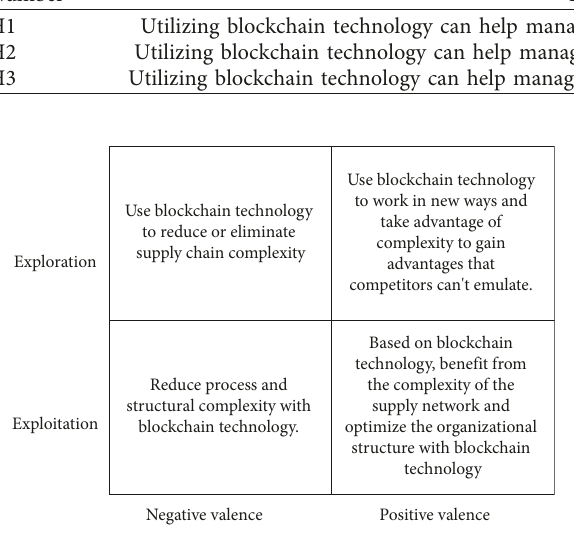
Figure 5: Ambidexterity management of the supply network complexity by using blockchain technology.